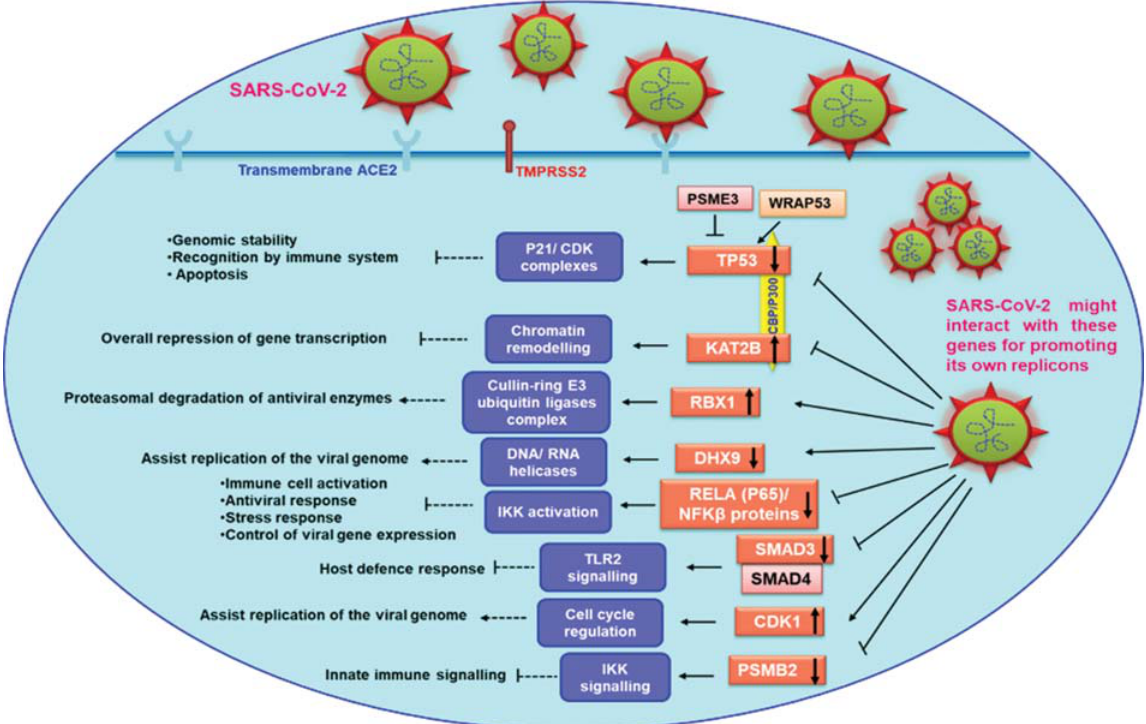
Fig. 3 Diagrammatic illustration of host-viral interactions of some of the hub genes that came out from our network-based meta-analysis. The host – virus interactions participation of some of our hub genes is suggestive that these pathological conditions strengthens a favorable environment for virus and further aids in aggravating its viral load and deterioration of patients. ACE2, angiotensin-converting enzyme 2; CDK1, cyclin dependent kinase 1; DHX9, DExH-box helicase 9; IKK, i- κ -kinase; KAT2B, lysine acetyltransferase 2B; NF- κβ , nuclear factor kappa B; P21/ CDK, P21/cyclin-dependent kinase; PSMB2, proteasome β subunits 2 family; PSME3, proteasome activator complex subunit 3; RBX1, RING-box protein 1; RELA, REL-associated protein; SARS-CoV-2, severe acute respiratory syndrome-coronavirus-2; TLR2, toll-like receptor 2; TMPRSS2, transmembrane serine protease 2; TP53, tumor protein 53; WRAP53, WD repeat containing antisense to